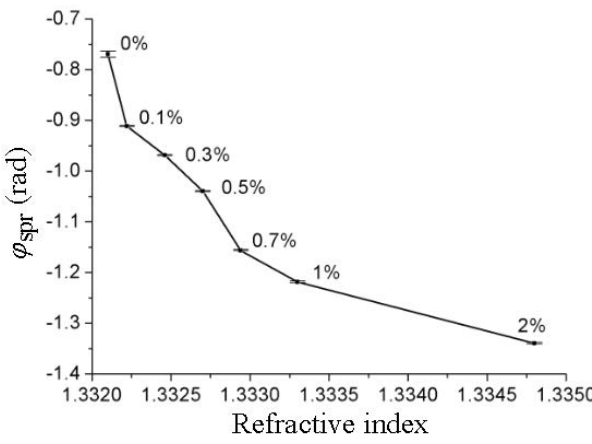
Figure 5: The mean values of the sensor response φ spr with differ- ent glycerine solutions. Adapted from Ref. [27].